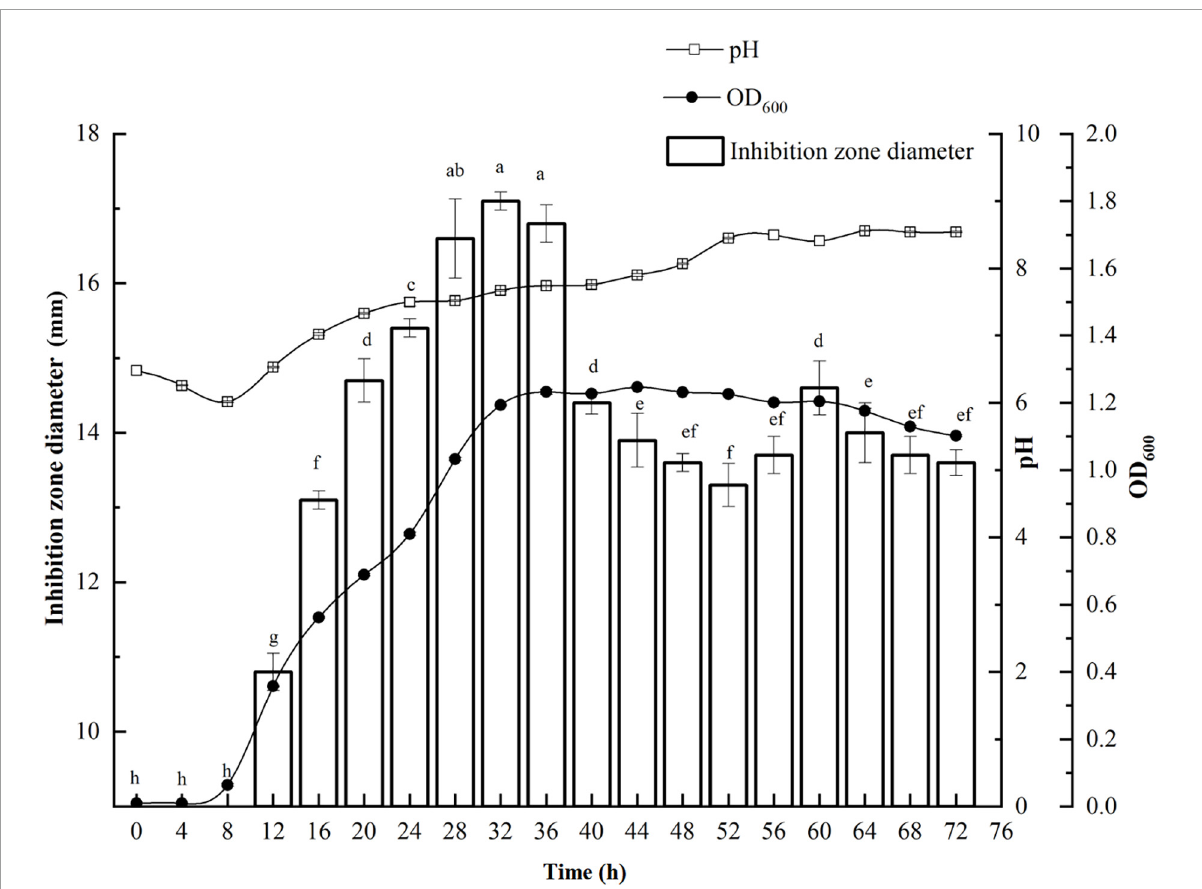
FIGURE1 Growth kinetics of P. thiaminolyticus SY20 against E. coli ATCC 25922. The line chart represents the change in the bacterial density and pH in the fermentation broth with the culture time, respectively. The histogram represents the antimicrobial activity of the fermentation supernatant against E. coli ATCC 25922, inhibition zone diameter is expressed as mean ± standard deviation ( n = 3), each column followed by the different letter is significantly different at the 5% level.